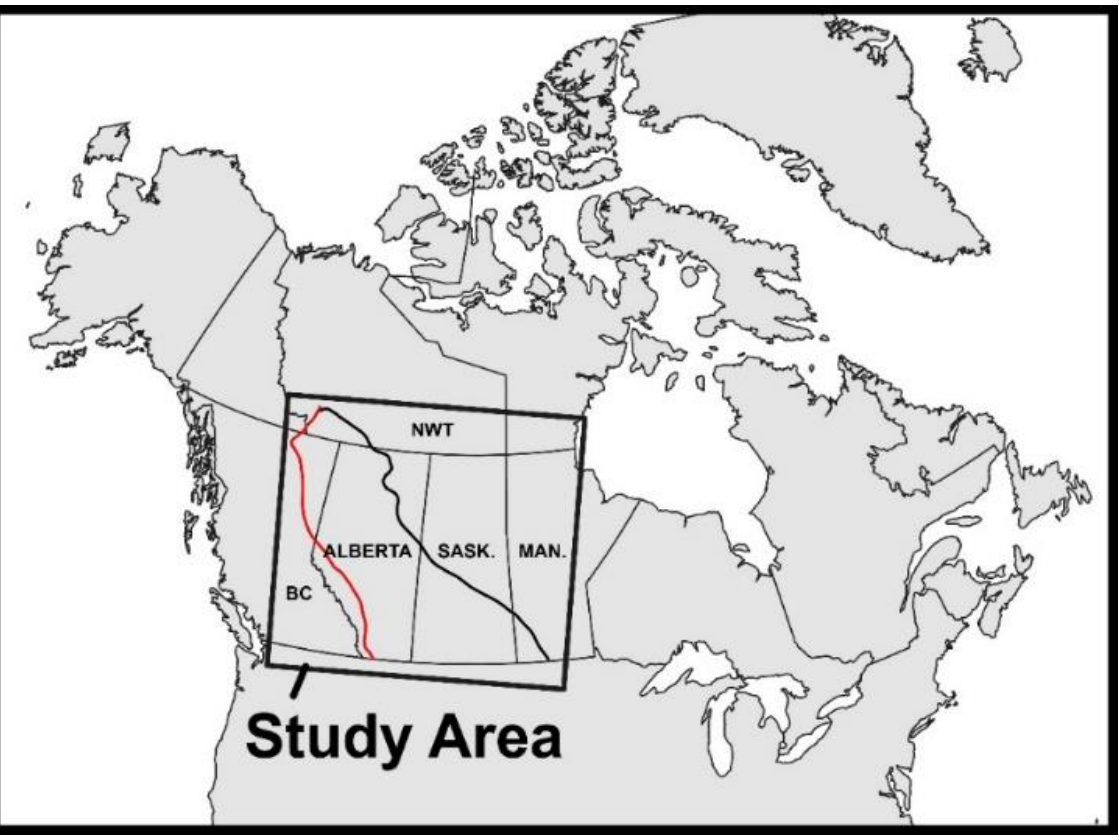
Figure 1. Map of Canada showing the study area (rectangle). Provinces and territories that are considered in the study are indicated along with the outline of the Western Canada Sedimentary Basin (WCSB). BC = British Columbia, NWT = Northwest Territories, Sask. = Saskatchewan, Man. = Manitoba. The red line depicts the western margin of the WCSB which is defined by the deformation front of the Canadian Rocky Mountains. The black line shows the eastern edge of our study defined by 1 km sedimentary thickness.